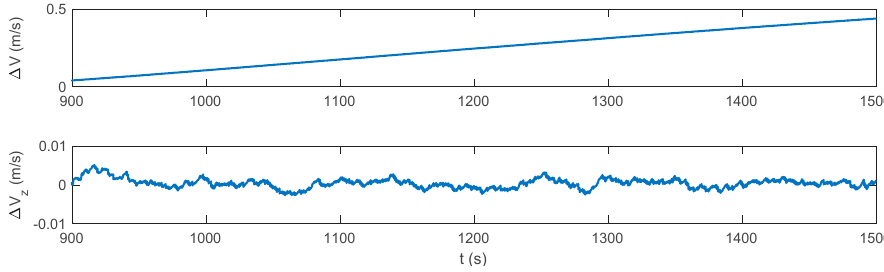
Figure 14. Velocity error of the pure INS solution during the DVL outage. Sensors 2017 , 17 , 2030